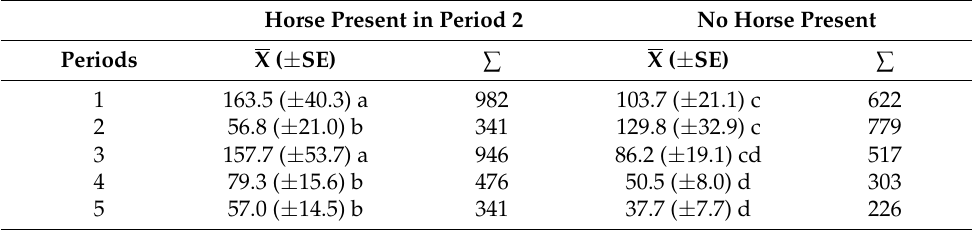
Table 2. Mean ( ± SE) and total numbers of mosquitoes captured per 20 min trapping period near a feeding slip stall with an MM-Pro trap from 1–21 October 2004 at the UF Horse Teaching Unit, Gainesville, FL, USA, showing the effect when a horse is placed in the stall adjacent to the trap during period 2 ( n = 6).